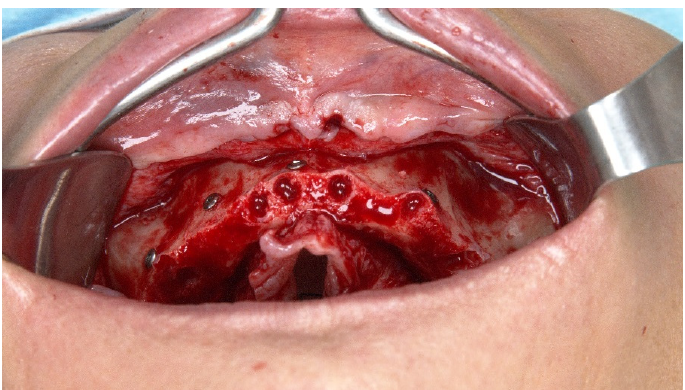
Figure 4. Perioperative intraoral photograph illustrating the insertion of the TriStar screws.